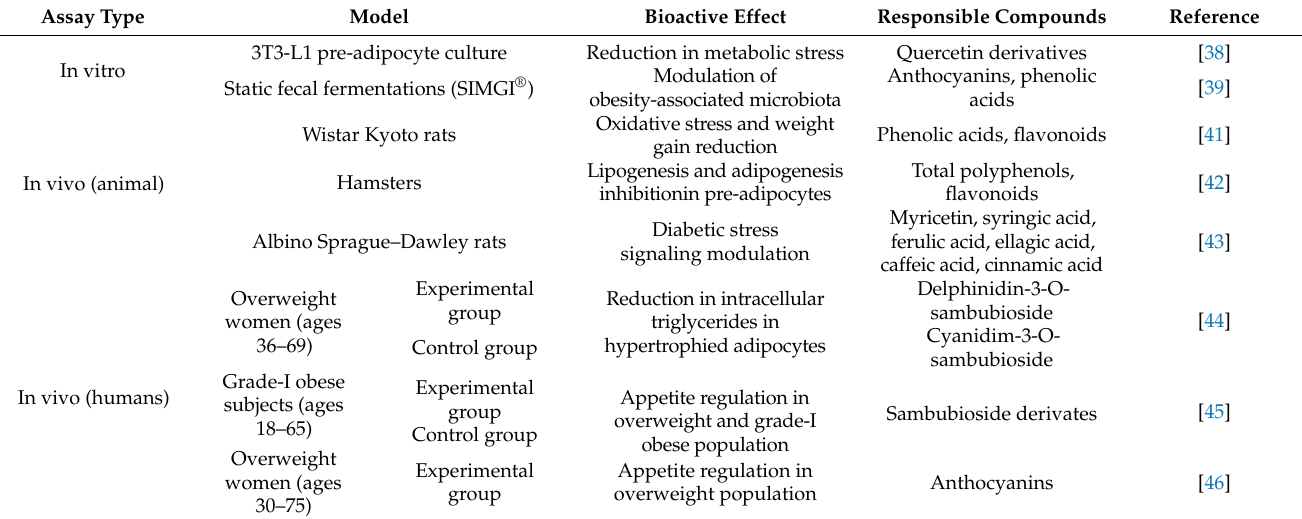
Table 2. Bioactivity of phenolic compounds from Hibiscus genera extracts on